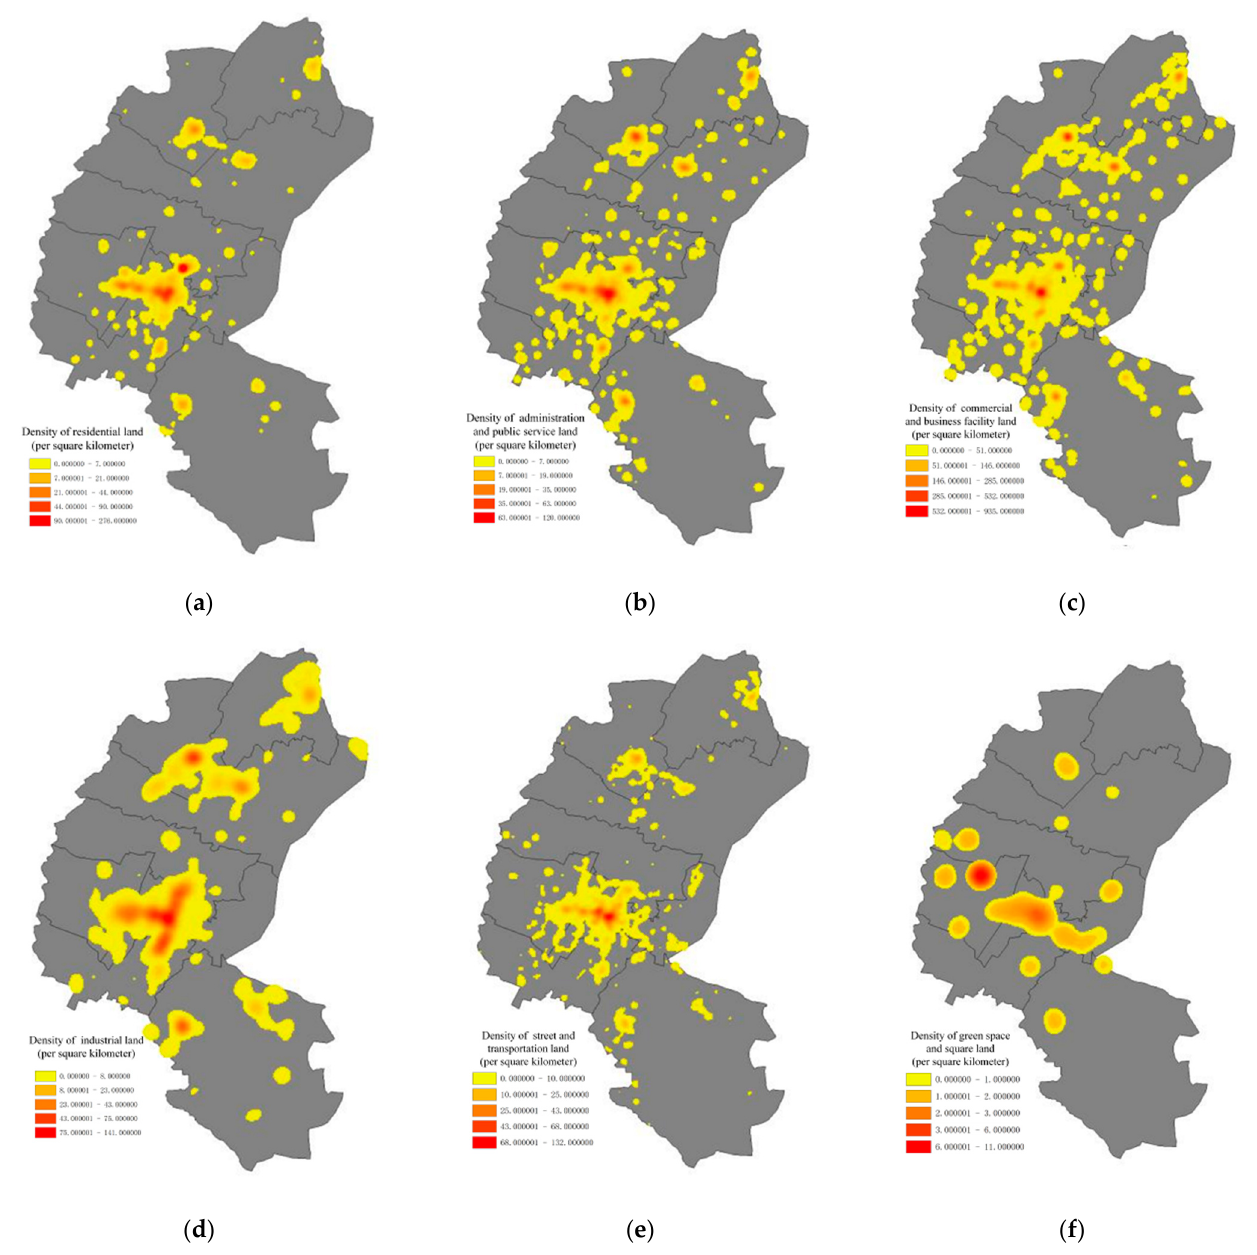
Figure 5. ( a ) Spatial distribution of residential land; ( b ) spatial distribution of administration and public service land; ( c ) spatial distribution of commercial and business facility land; ( d ) spatial distribution of industrial land; ( e ) spatial distribution of street and transportation land; ( f ) spatial distribution of green space and square land.